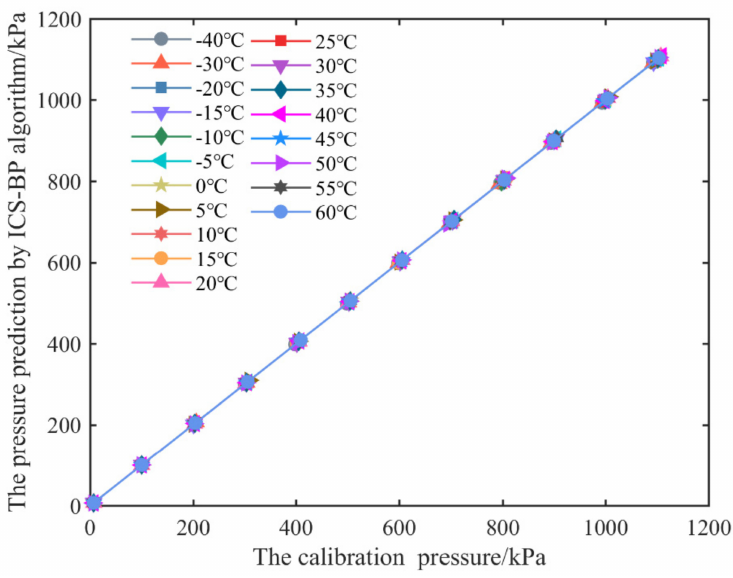
Figure 6. Relation curve between calibration pressure and predicted pressure by ICS-BP algorithm.